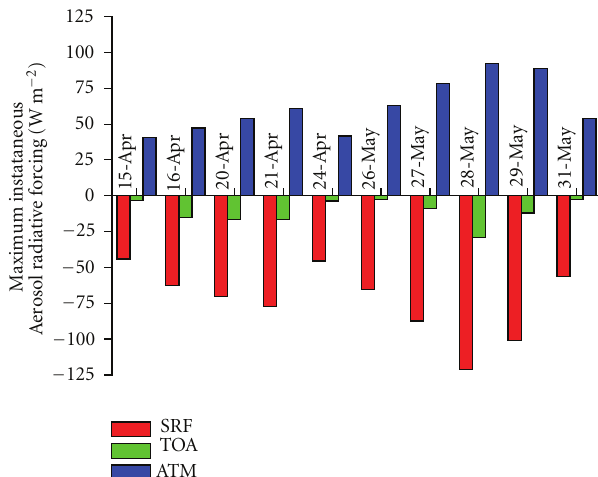
Figure 10: Same as in Figure 9, but for the maximum instantaneous ARF